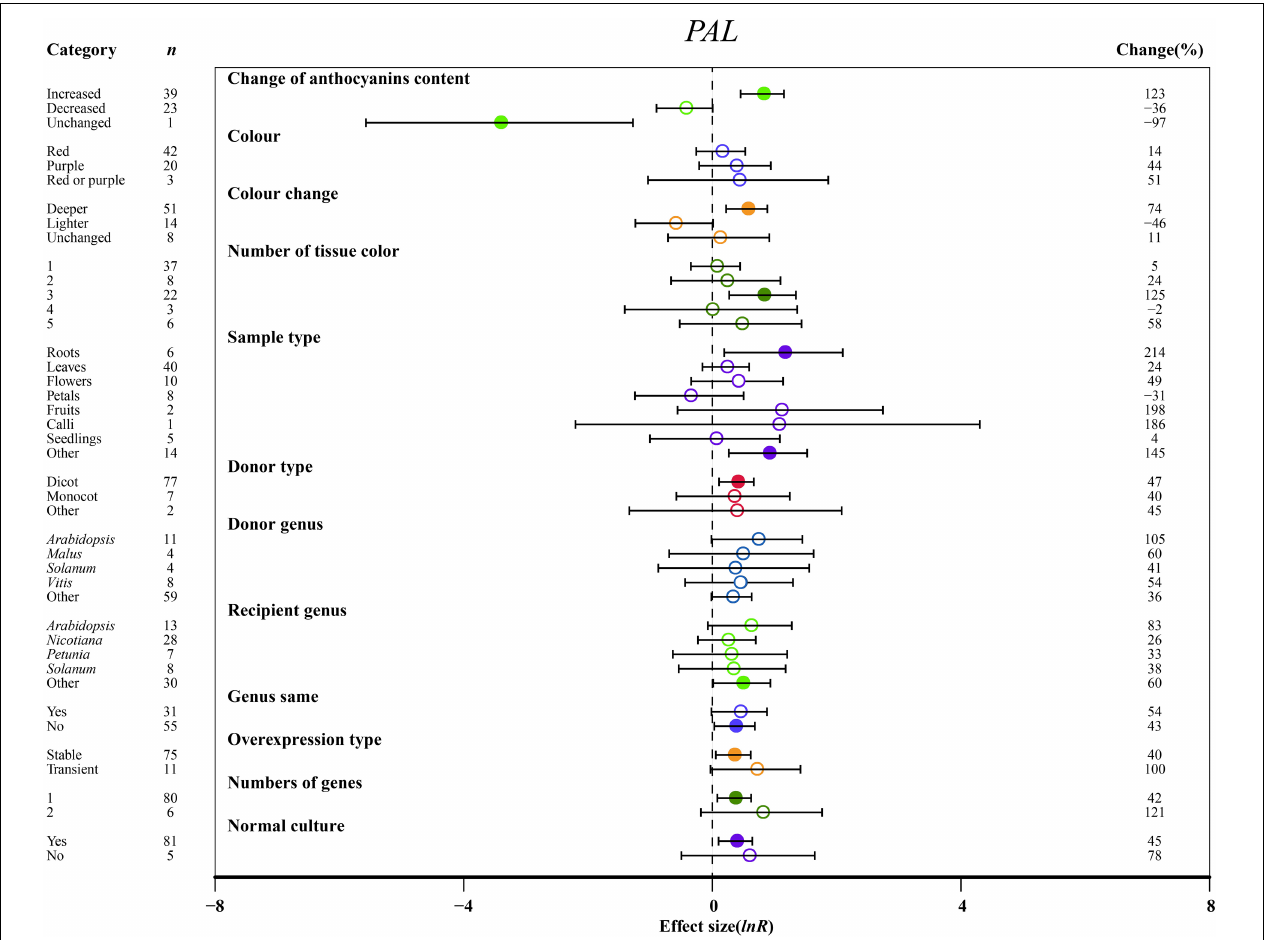
FIGURE 5 | Summary effects (ln R ) of the influence of MYB overexpression on PAL expression in plants. Ratios are unit-less. The ratios illustrate the strength of MYB overexpression on the summary effects of PAL expression compared with the controls. Circles and horizontal bars indicate the summary effects and the 95% CI of twelve (owing to insufficient studies, “recipient type” not analyzed) moderator variables, respectively. n represents the number of studies. Subgroup list levels (subgroups or categories) of each moderator. The percent change (to the right of plots) refers to the raw percentage increase or decrease in PAL expression induced by overexpression of MYB . The moderator variables of the examined plants are colored and distinguished by different colors. Closed and open circles indicate the effects of significance and insignificance,